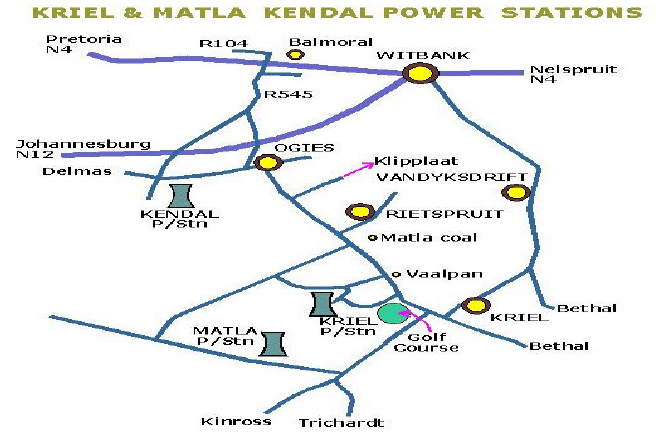
Figure 1. Map of Matla power station 14